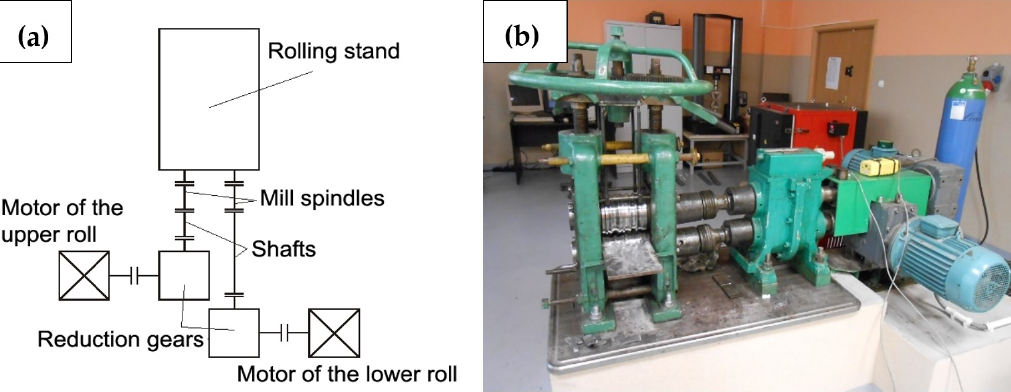
Figure 2. The layout of the D150 two-high rolling mill ( a ) and a general view ( b ) [34]. In the literature on the processes of asymmetric rolling of aluminum alloys, authors used various asymmetry coefficients up to 2.5 [35–38], but there are also examples of very large asymmetry coefficients of 4.0 [39]. In the work on the basis of the literature data as well as the earlier studies of the authors concerning the asymmetric rolling processes [33,34], the asymmetry coefficients ranging from 1.2 to 1.6 were used, which should reveal the influence of the asymmetry on the properties of the rolled material. The rolling processes in symmetry and asymmetry of the AA2519 alloy were conducted in four variants: variant